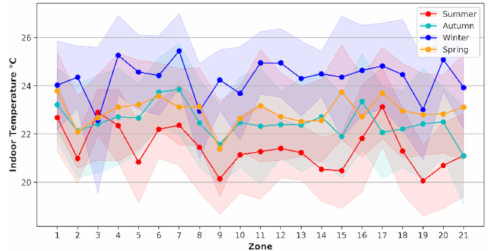
Figure 14. Indoor temperatures mean over the seasons (hues account for standard deviation).